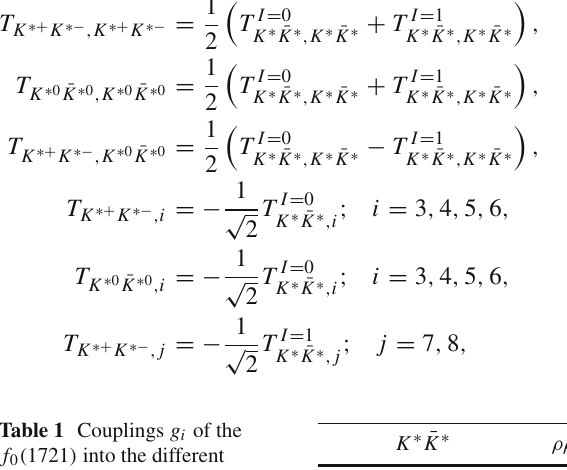
Table 1 Couplings g i of the f 0 ( 1721 ) into the different channels from Ref.